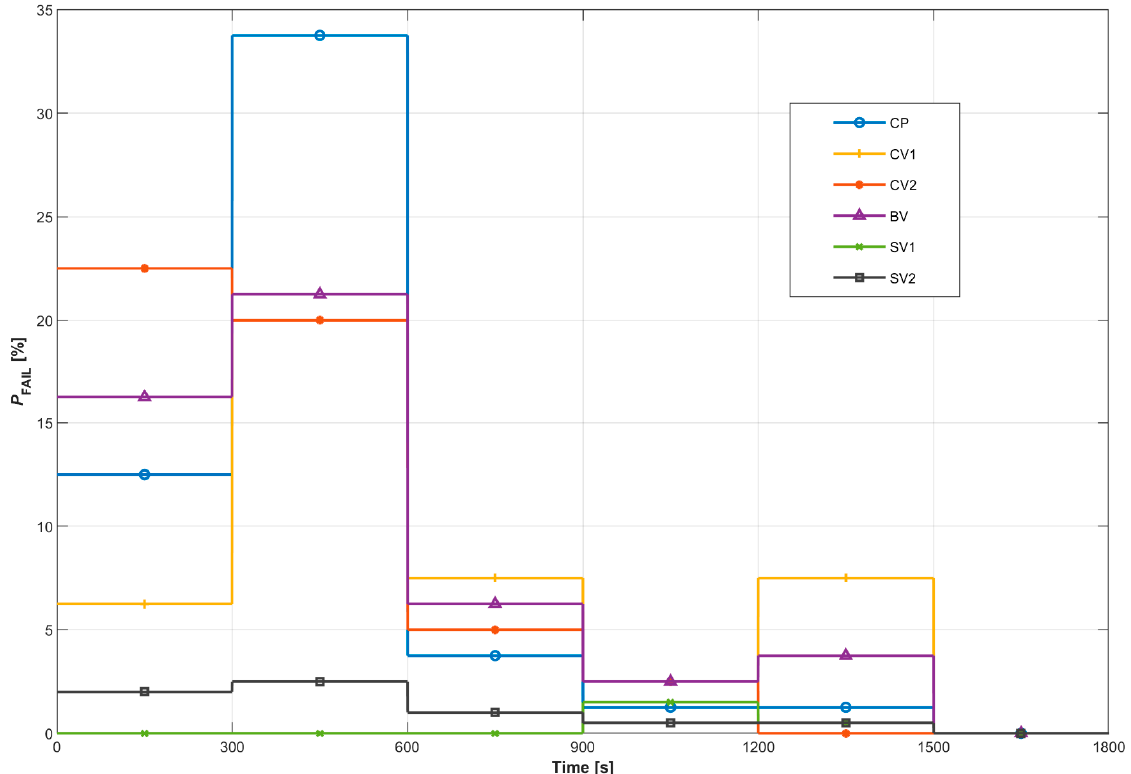
Figure 12. Conditional probability of failure (cid:1842) (cid:3007)(cid:3002)(cid:3010)(cid:3013),(cid:3039) ((cid:1857)|(cid:1855)) of each component e for cluster c = 4, as a function of time l .